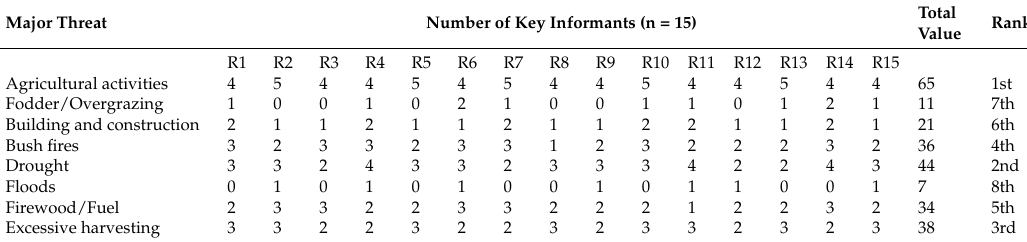
Table 5. Priority ranking of factors perceived by key informants as threats to medicinal plants in